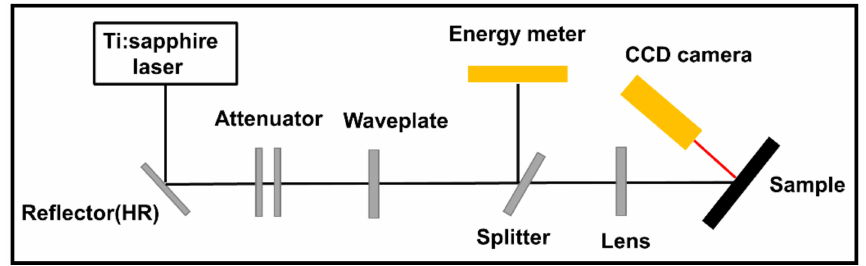
Figure 5. Experimental setup used for laser damage test.